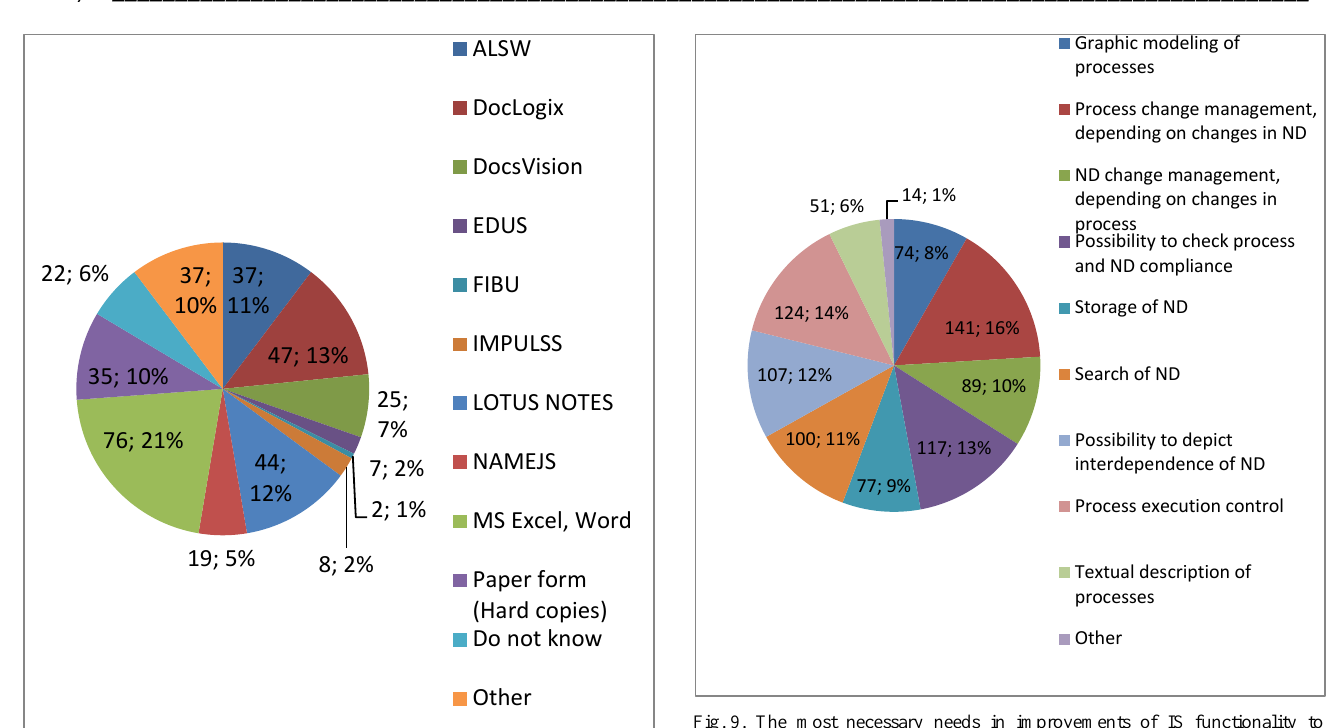
Fig. 9. The most necessary needs in improvements of IS functionality to ensure ND and BP joint